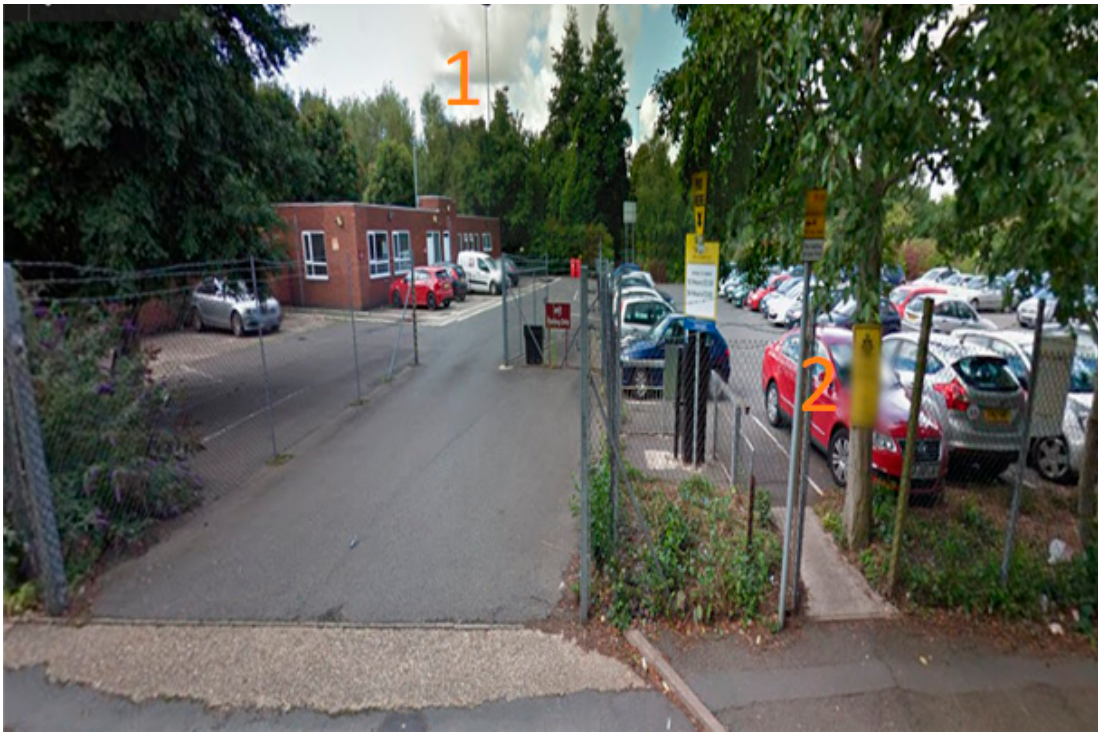
Figure A1. Location 1 (Map data ©2017 Google).